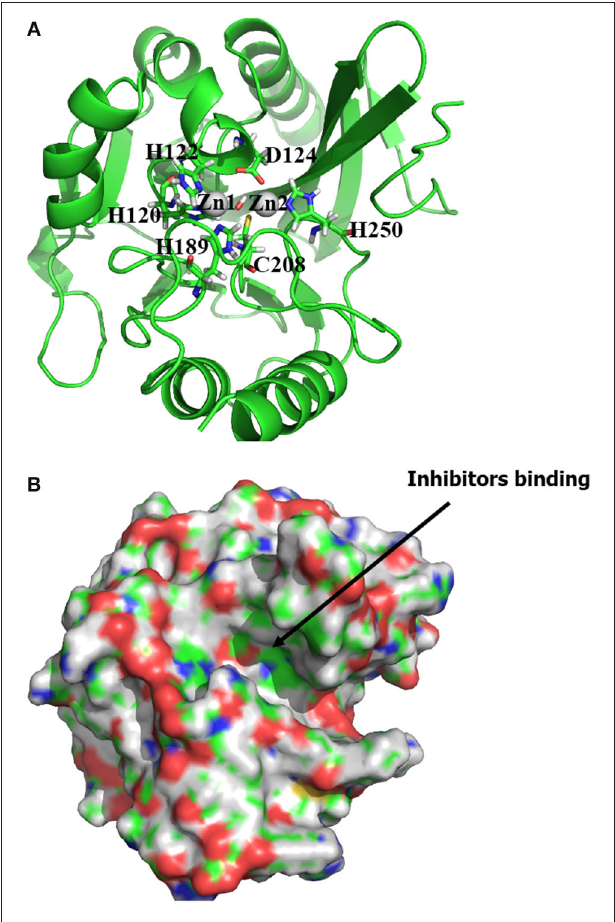
FIGURE 1 | (A) Active binding sites of NDM-1 (PDB 3Q6X, Zhang and Hao, 2011), with the Zinc ions and the coordinated residues highlighted in sphere and stick, respectively; (B) surface presentation of the NDM-1. The general location for the ligand binding is arrowed. Figures were prepared using PyMol (Schrodinger, 2012).